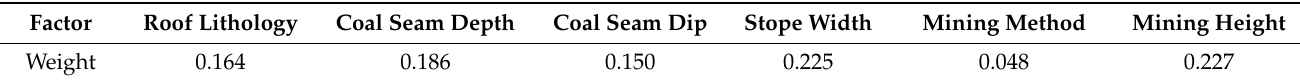
Table 4. FANP calculation